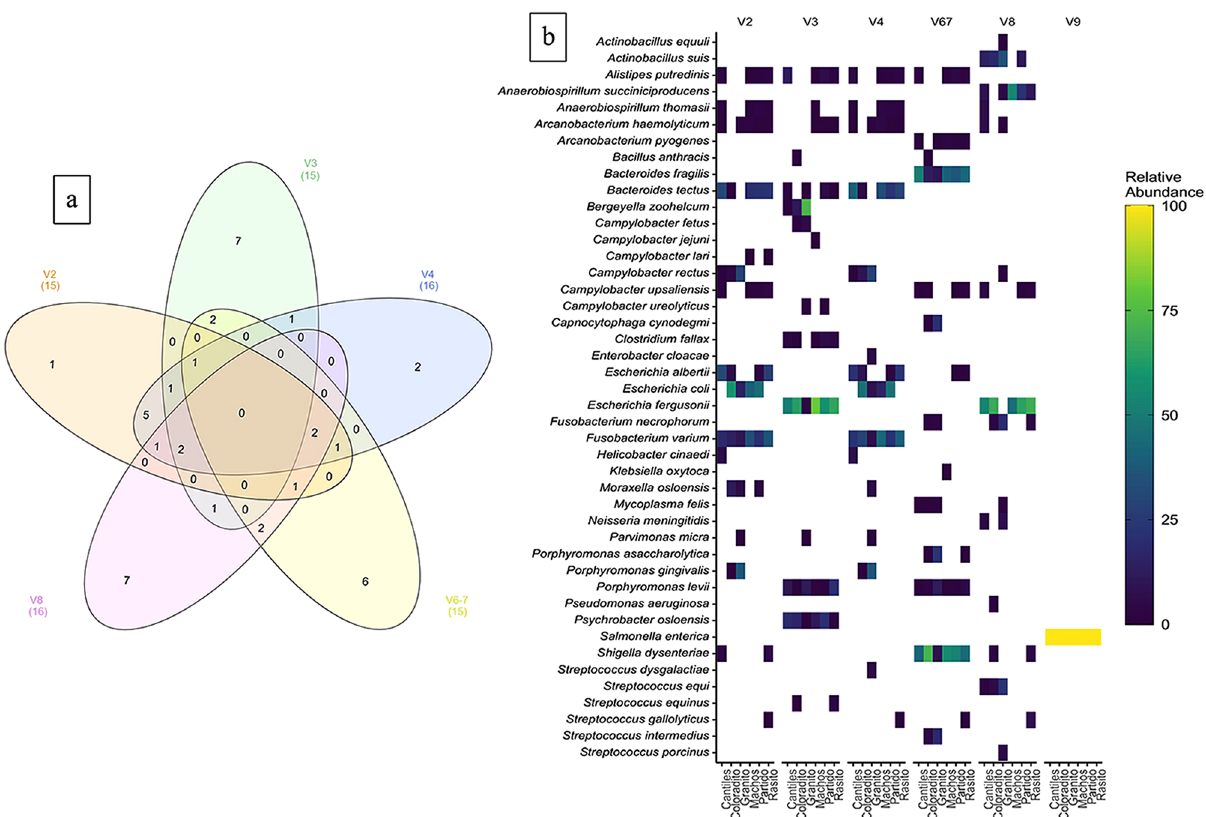
Figure 3. Number of exclusive or shared human pathogenic bacteria among the analyzed hypervariable regions (V2 to V9) ( a ) and geographic areas (i.e., rookeries) ( b ). To facilitate Venn diagram interpretation, the V9 region was not included. However, an additional exclusive human pathogenic species, Salmonella enterica , should only be considered for the V9 region. The heat map is based on a log2 transformation of the relative abundances of the pathogenic species detected for each hypervariable region (V2 to V9) and between all sampled rookeries (Rasito, Partido, Machos, Granito, Coloradito, and